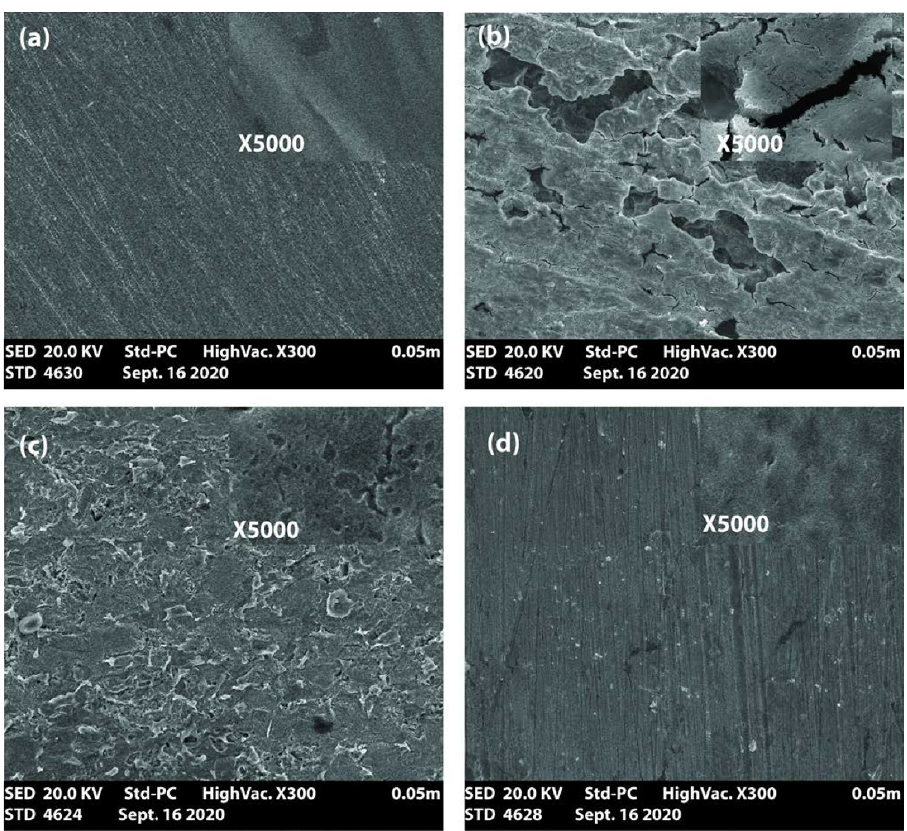
Figure 7. The SEM image of LCS specimens of ( a ) before treatment with 0.5 M H 2 SO 4 ; ( b ) corroded; ( c ) inhibited by APPH ; and ( d ) inhibited by APPH with 100 mM